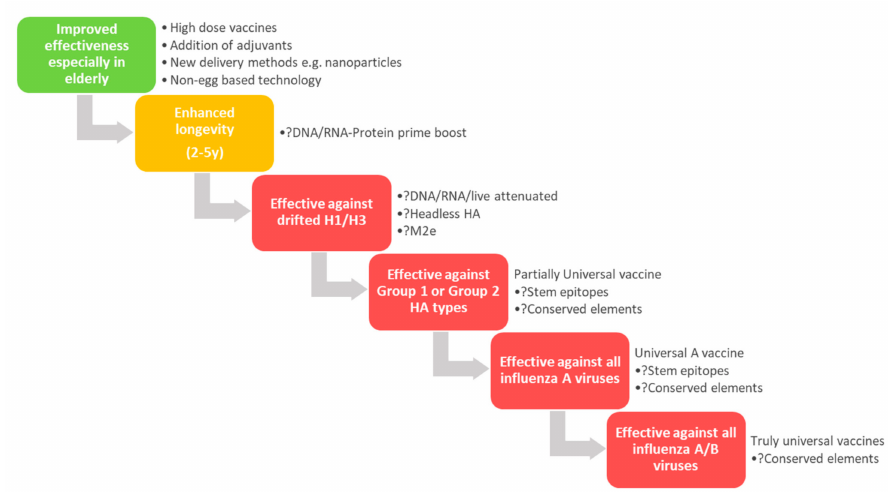
Figure 1. Potential steps and technologies to improve influenza vaccines. Stepwise improvements that might lead to the eventual generation of an e ff ective universal influenza vaccine. Achieved (green), partially achieved (yellow) and in-development / not achieved (red). Listed beside the steps as dot points are strategies that might be used to achieve these outcomes, with question marks indicating strategies that are still in development or have not achieved this outcome to